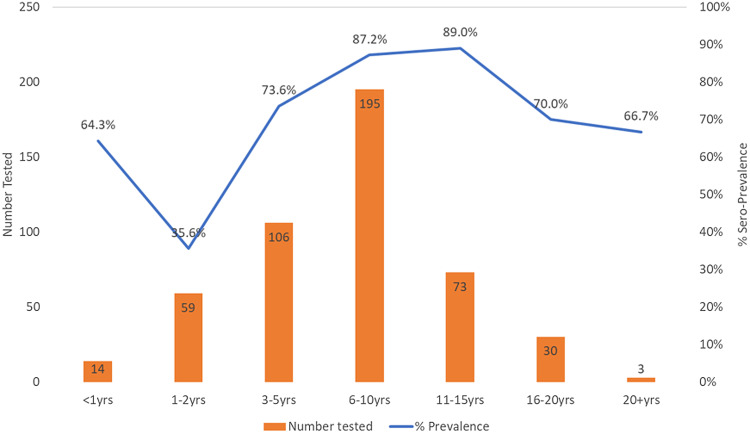
Distribution of MERS-CoV seropositivity in camels by age categories, 2018. Dataset includes serum samples from 493 randomly selected camels from among 29 herds in Marsabit Central, Kenya. Samples were tested for anti-MERS-CoV antibodies using a microneutralisation assay and the % seropositivity (blue line) and the number of camels tested (orange bars) were plotted against camel age categories as shown in the chart.